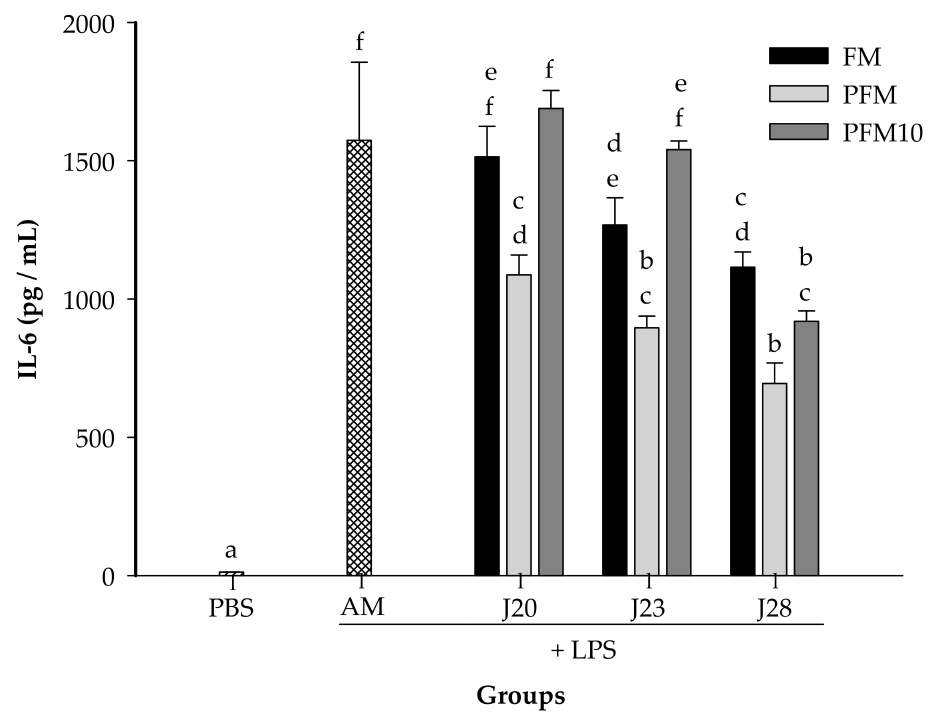
Figure 4. Serum concentrations of IL-6. Wistar rats were fed with fermented milk (FM), pasteurized fermented milk (PFM), fractions <10 kDa of PFM (PFM10) with Lactobacillus J20, J23 or J28; after 4 weeks, rats were injected with lipopolysaccharide, and sacrificed after 6 h post-injection. Control groups included: acidified milk (AM) injected with LPS; or phosphate buffer saline (PBS) without LPS. Bars represent means ± SE ( n = 6). Different letters indicate significant differences ( p < 0.05) among all